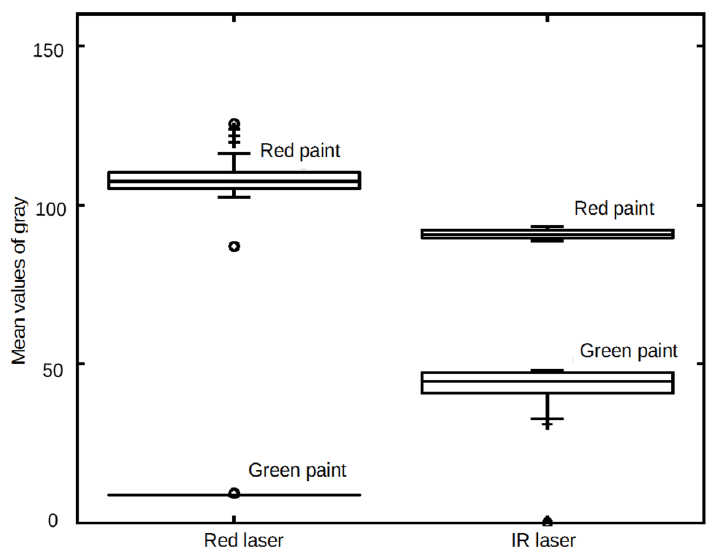
Figure 4. Mean values of the light intensity from the speckle histograms of the lasers shinning a red and a green coating in the first five minutes of the drying process.